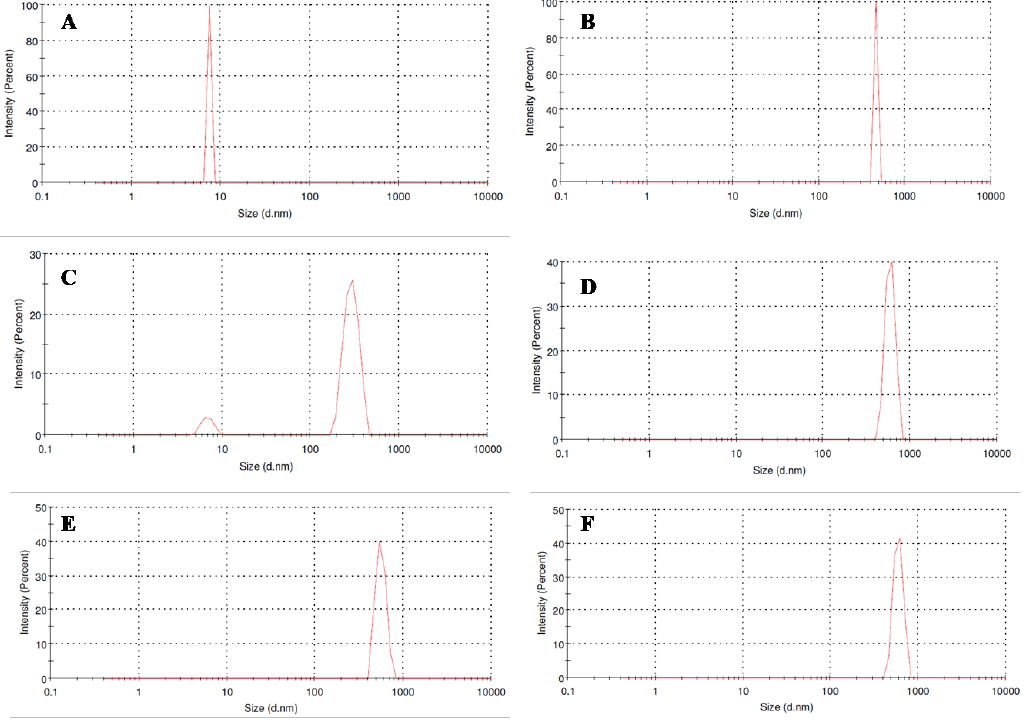
Figure 5. Particle size analysis of ( A ) LcrV, ( B ) dextran, ( C ) formulation PD1 within an hour, ( D ) PD1 after an hour at 30 °C (room temperature),( E ) PD1 after 1 week of storage at 30 °C, and ( F ) PD1 after 3 weeks of storage at 30 °C.